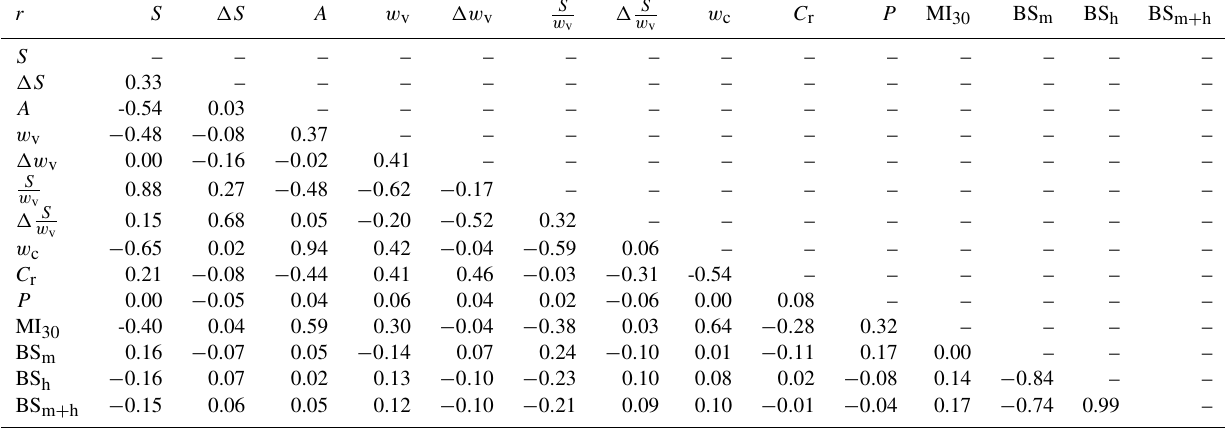
Table A1. Pearson correlation coefficients ( r ) for the independent variables used in our statistical analysis in Skin Gulch. Independent variables include channel slope ( S ), (cid:49)S , contributing area ( A ), valley width ( w v ), change in valley width ( (cid:49)w v ), slope / width ratio ( S ), channel width ( w c ), confinement ratio ( C r ), total precipitation ( P ), maximum 30min intensity (MI 30 ), change in slope / width ratio ( (cid:49) S w v percent burned at moderate severity (BS m ), percent burned at high severity (BS h ), and percent burned at moderate-to-high severity (BS m + h ).